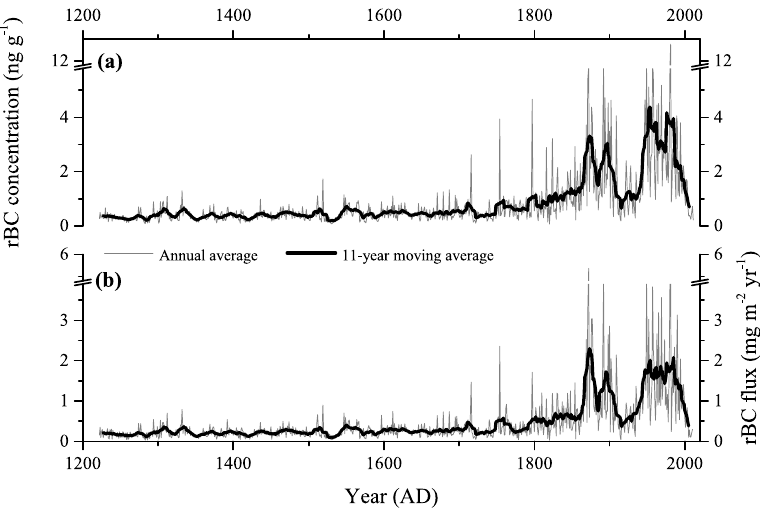
Figure 3. The rBC long-term trends from the combined LF-09 and LF-11 cores, expressed as (a) rBC concentrations and (b) rBC